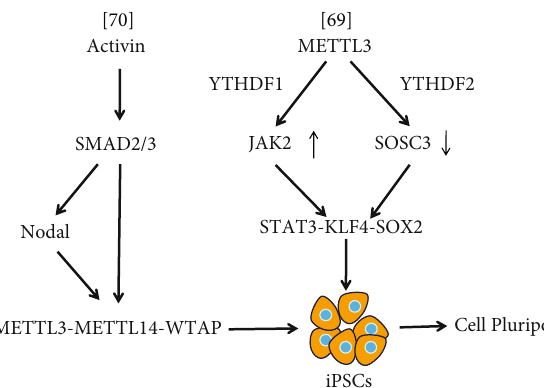
Figure 3: The schematic of interplays between Activin/Nodal and STAT3-KLF4-SOX2 signaling pathway with m 6 A modulators in regulation of iPSC